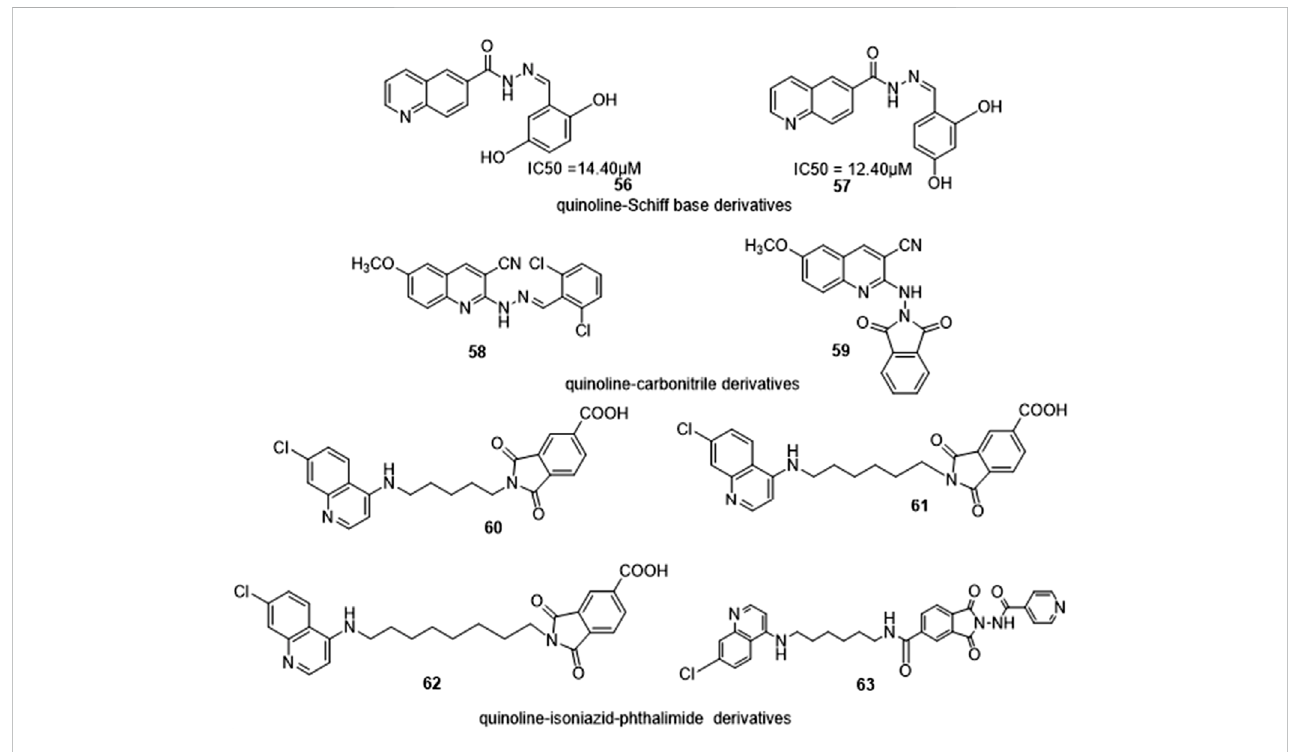
FIGURE 13 Some quinoline derivatives with reported